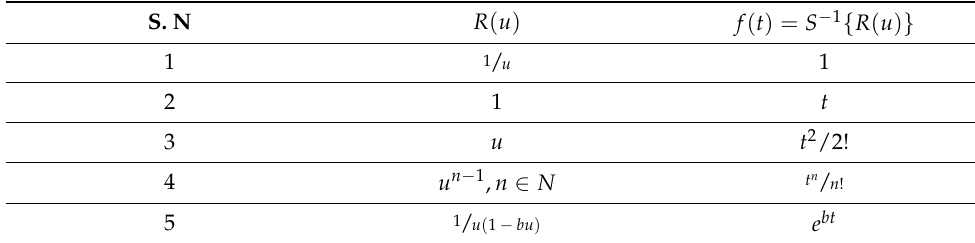
Table 2. Inverse ST of Frequently Encountered